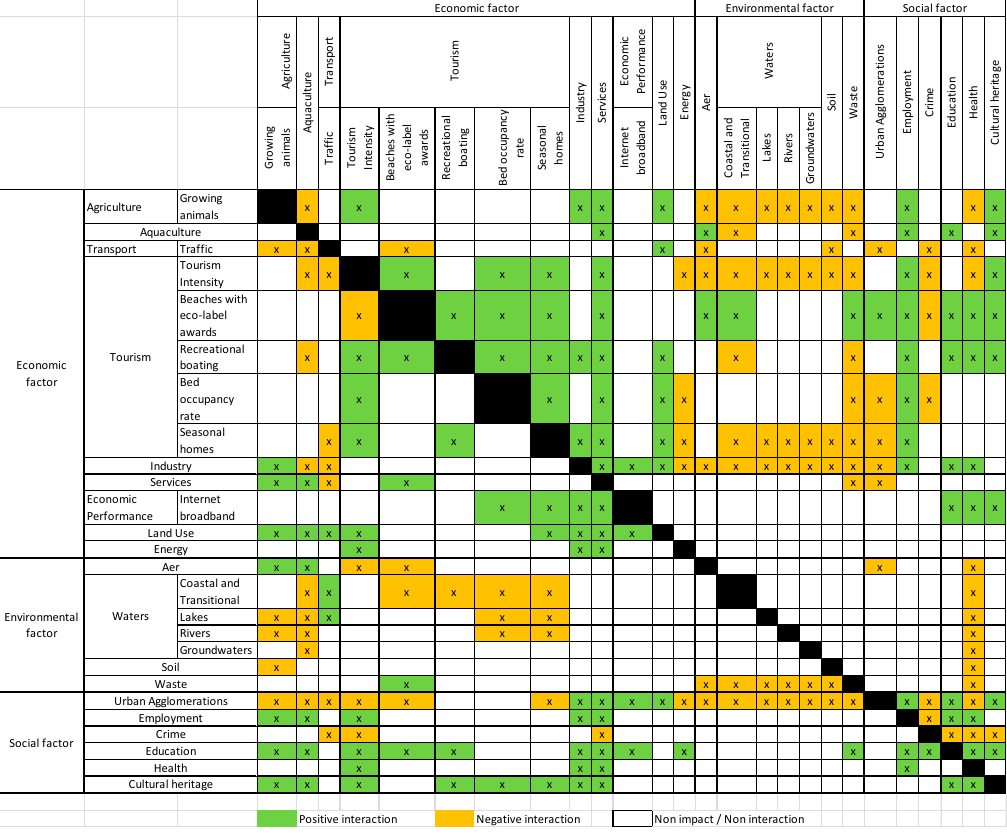
Table 1. Interaction mode between economic, environmental, and social factors (authors).